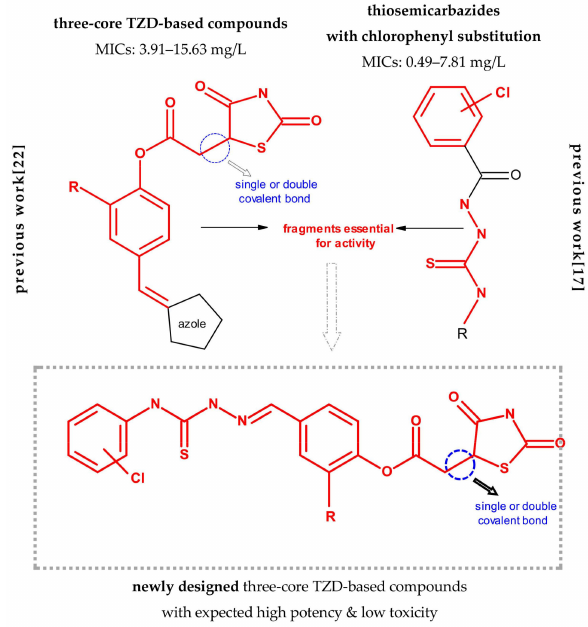
Figure 1. Design of novel three-core thiazolidine-2,4-diones (TZD)-based compounds with chlorophenyl